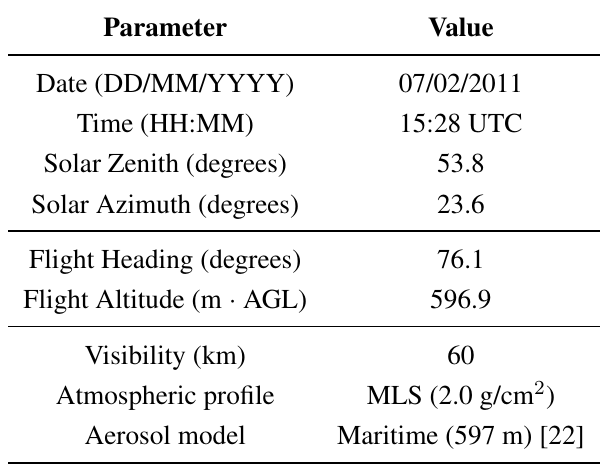
Table 2. Geometry, flight and model parameters (AGL; Above Ground Level).